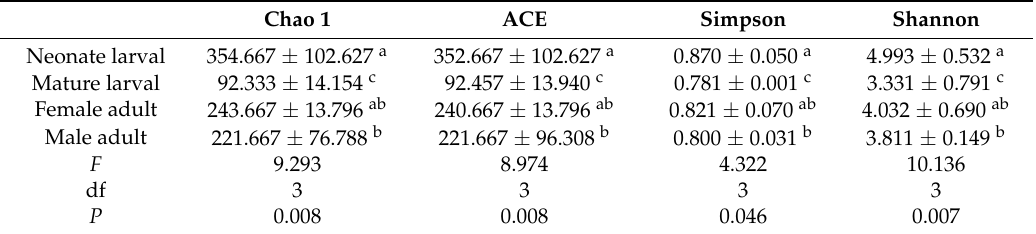
The data represent the mean ± standard deviation. Different small letters indicated significant difference between sites for that parameter. Means compared using one-way ANOVA, within each group, bars with different letters are significantly different at p < 0.05